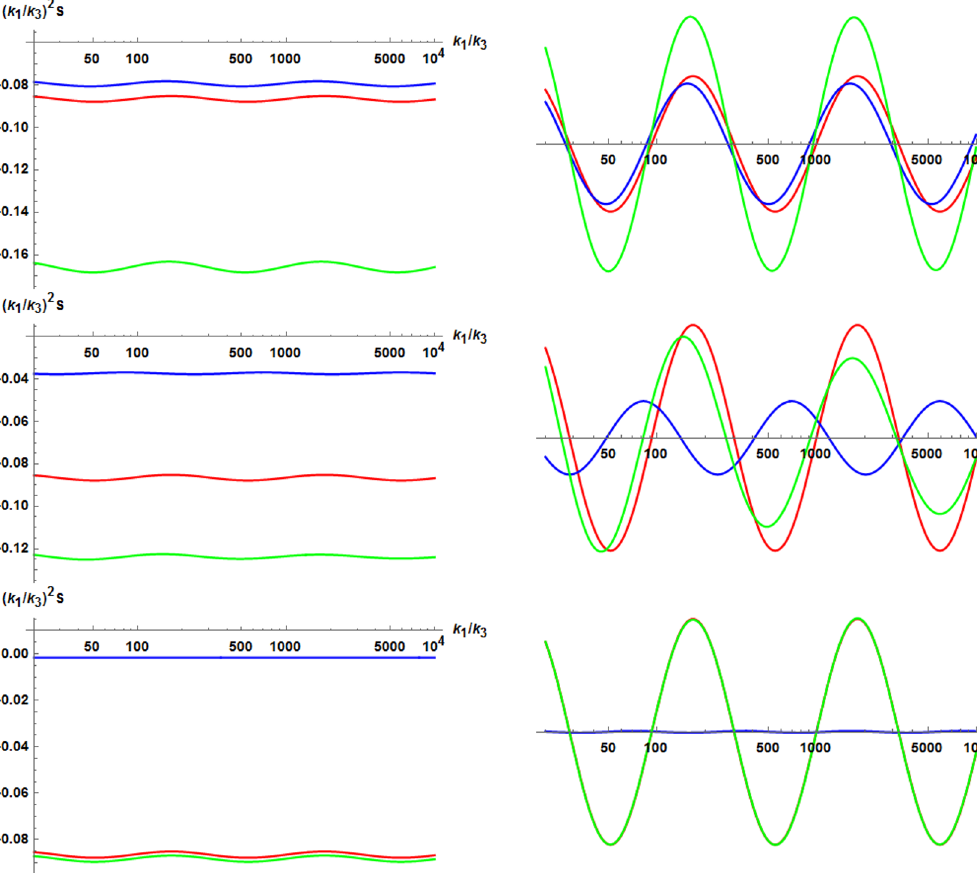
Figure 2 . Left : momentum ( k 1 /k 3 ) dependence of ( k 1 /k 3 ) 2 S . The red, blue, and green lines denote S 11 , S 22 , and S = S 11 + S 22 , respectively. The masses are changed as ( m 1 , m 2 ) /H = (2 , 2 . 01) , (2 , 2 . 1) , and (2 , 2 . 5) from top to bottom. In all of the figures, we take g Right : detailed view of superposition. The constant offsets such as the last term in eq. (4.2) are extracted to compare the three lines. In the last figure with m lines are